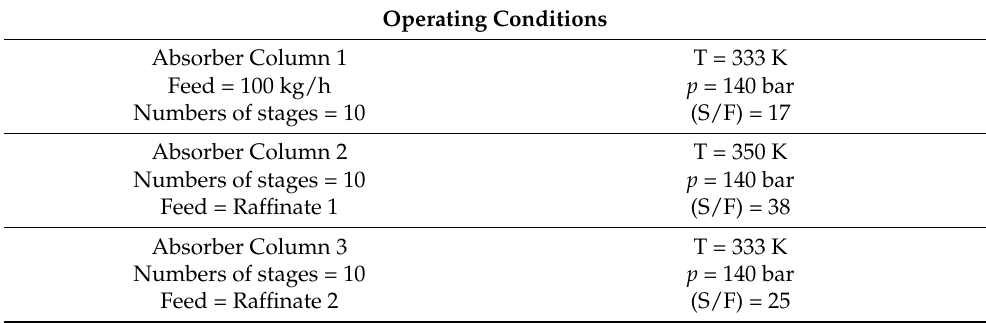
Table 1. Operating conditions of the simulation of the OLP deoxygenation process, using SC-CO 2 as solvent, with the help of the chemical process simulator Aspen-HYSYS 8.6 (Aspen One,